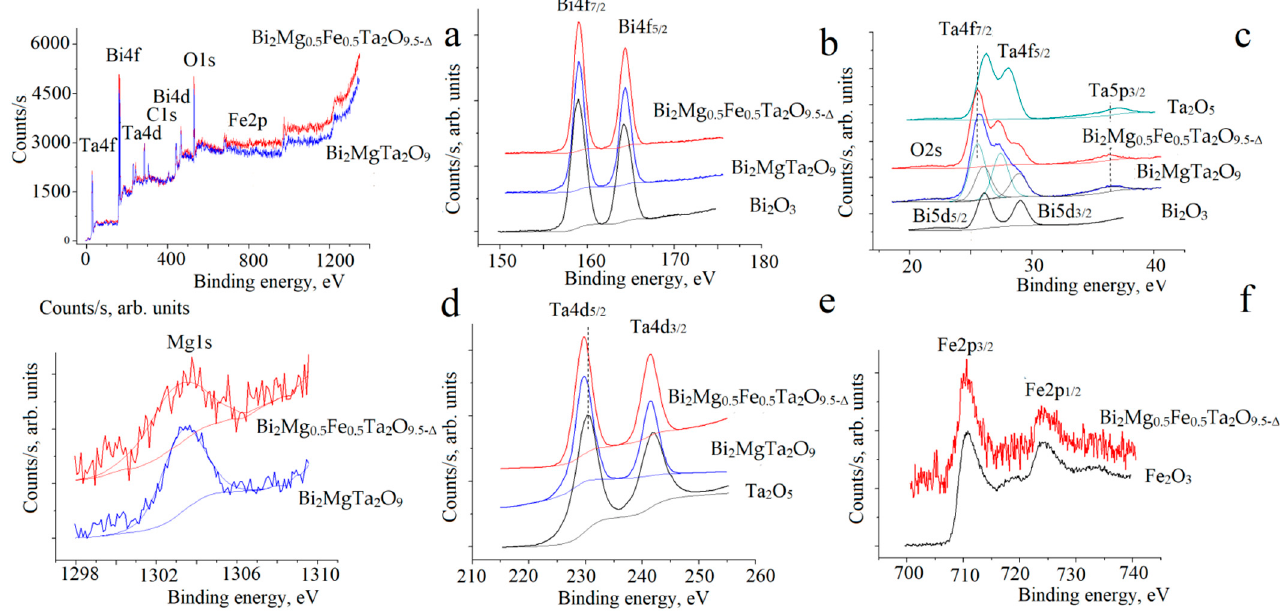
Figure 6. Survey XPS spectra of Bi 2 MgTa 2 O 9 and Bi 2 Mg 0.5 Fe 0.5 Ta 2 O 9.5 − ∆ ( a ); Bi4f spectra ( b ). For comparison, the spectra of Bi 2 O 3 are shown; XPS spectra of tantalum and bismuth atoms ( c ); Mg1s spectra ( d ); Ta4d spectra ( e ); Fe2p spectra of Bi 2 Mg 0.5 Fe 0.5 Ta 2 O 9.5 − ∆ and of Fe 2 O 3 ( f ).